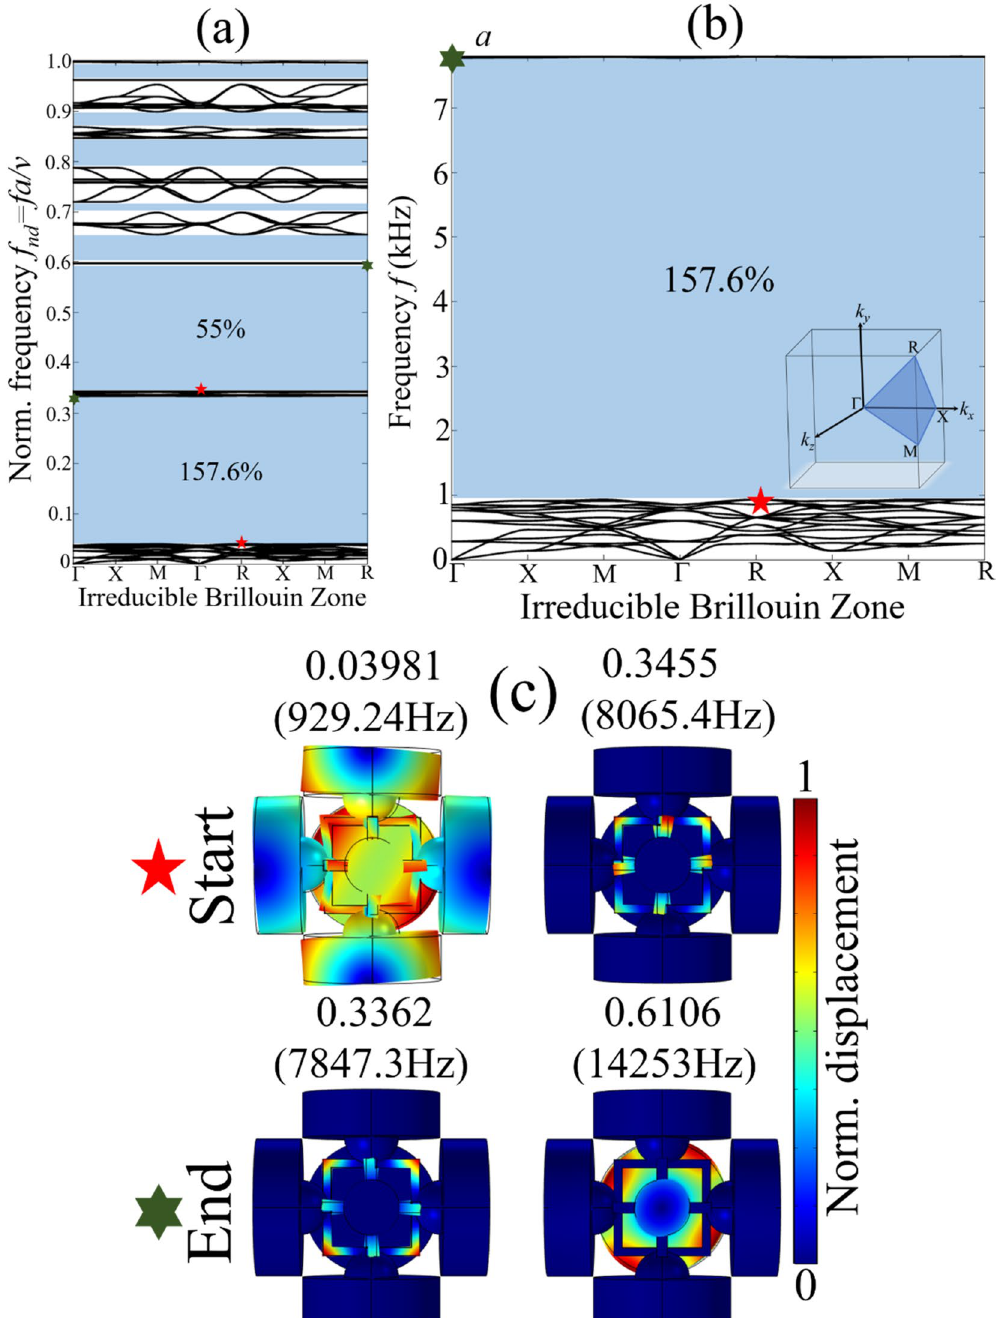
Figure 3. Prototype 2- numerical dispersion spectra: ( a ) complete band structure with normalized frequency; ( b ) the widest first BG with �ω/ω c of 157.6%; and ( c ) vibration modes corresponding to the lower and upper bounding edges of